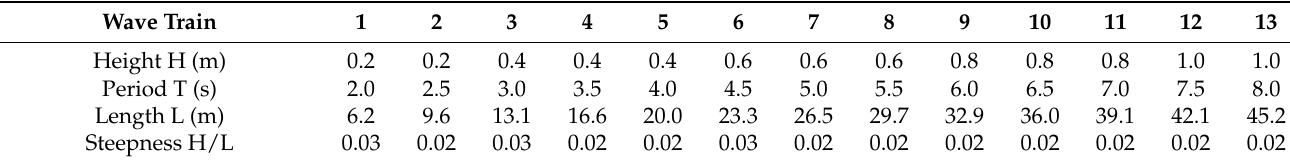
Figure 3. ( a ) Clamping of a live line for setup in the test rack. ( b ) Measurement of an individual mussel regarding the common conventions for mussel length, height and width. Table 1. Wave parameters for experiments at a water depth of 3.5 m.